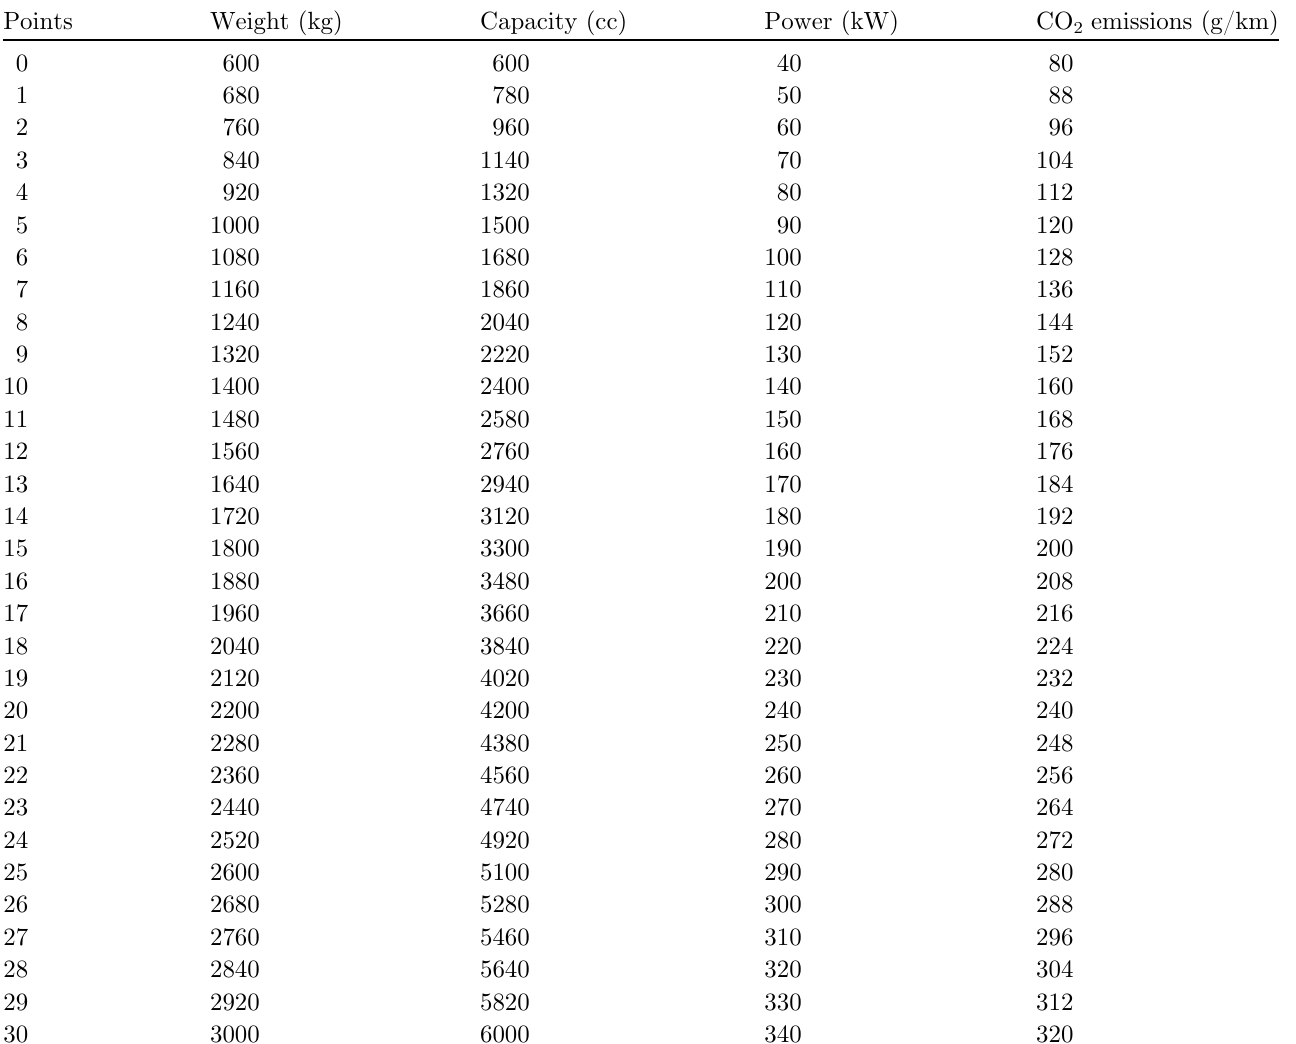
Table 2. Calculation of points to determine luxury energy taxable